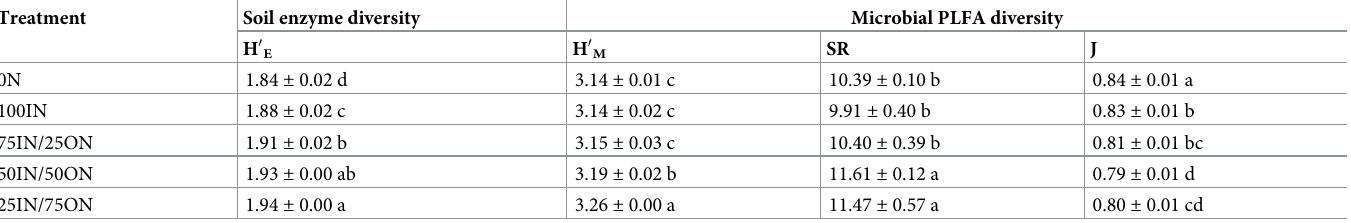
Table 6. Changes in soil microbial PLFA and enzyme diversity under different fertilization treatments. Data are means ± S.E., n = 3. Different lowercase letters indi- cate significant differences among different treatments at the P < 0.05 level. Treatment